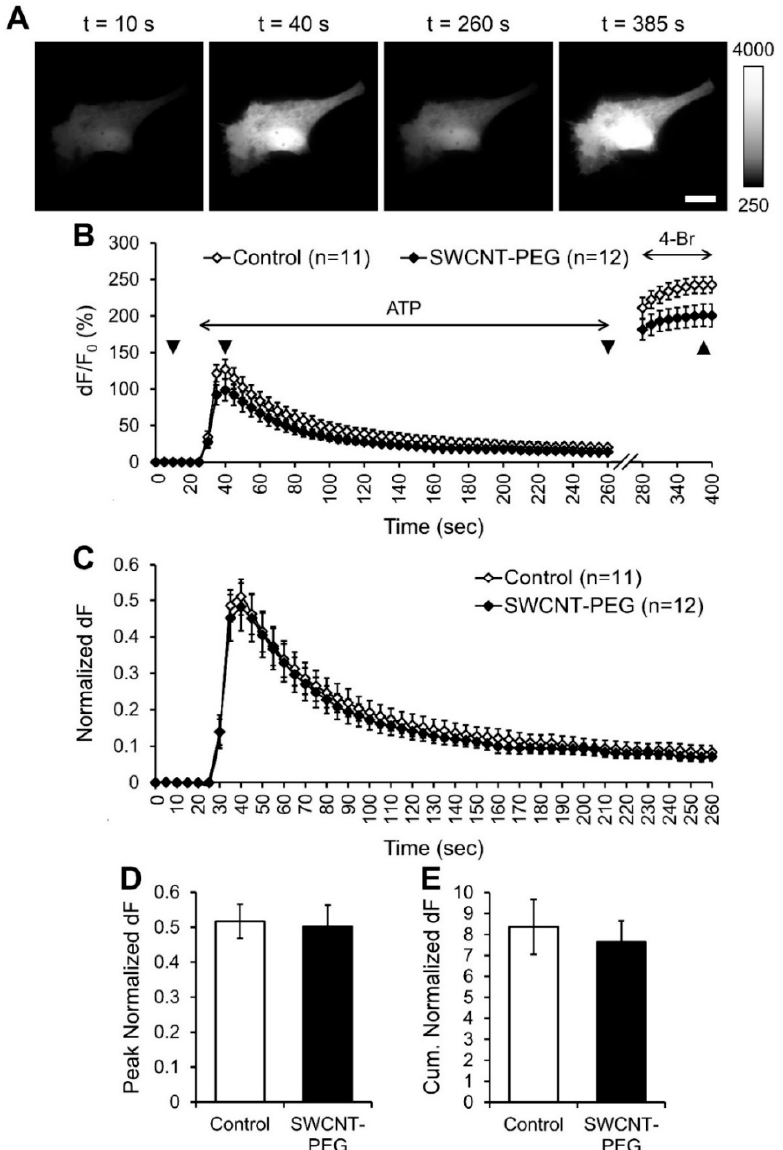
Figure 1. Single-walled carbon nanotubes chemically functionalized with polyethylene glycol (SWCNT-PEG) do not a ff ect the ATP-induced intracellular Ca 2 + elevations in cultured mouse cortical astrocytes. ( A ) Individual frames from the time-lapse imaging of RCaMP1h (intracellular Ca 2 + sensor) in a control astrocyte showing the changes in RCaMP1h fluorescence at selected time points (indicated with triangles in ( B )). Scale bar, 20 µ m. Gray scale is a linear representation of the fluorescence intensities of the pixels in the images, expressed in fluorescence intensity units (iu). ( B ) Time-lapse imaging of RCaMP1h fluorescence, reporting on the average intracellular Ca 2 + levels in astrocytes in the absence and the presence of SWCNT-PEG solute (5 µ g / mL). ATP (100 µ M) was bath applied to elicit an increase in intracellular Ca 2 + levels and the Ca 2 + ionophore 4-Bromo-A23187 (4-Br; 20 µ M) was bath applied to elicit maximal Ca 2 + response in astrocytes. The horizontal double-headed arrows indicate the times of addition of ATP and 4-Br containing external solutions. Changes in RCaMP1h fluorescence are expressed as dF / F 0 (%) after background subtraction. Number of astrocytes studied in each condition is shown in parentheses. ( C ) Changes in the RCaMP1h fluorescence of astrocytes shown in B, normalized to their maximal Ca 2 + response after the application of 4-Br, expressed as the normalized change in RCaMP1h fluorescence, dF. Traces in ( B ) and ( C ) show means + SEMs. ( D , E ) Summary graphs showing the average peak ( D ) and cumulative ( E ) normalized dF with